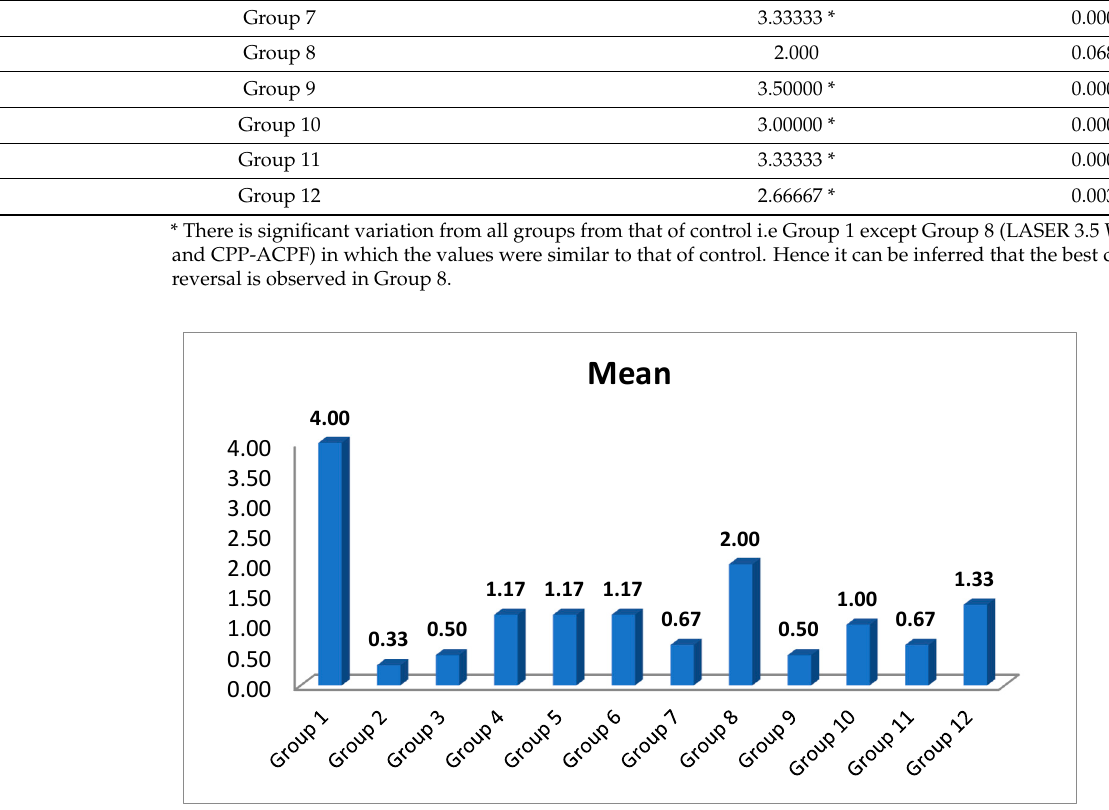
Figure 3. Comparison of mean values between the groups. Figure 3: The control was compared to the other surface treatment modalities. The